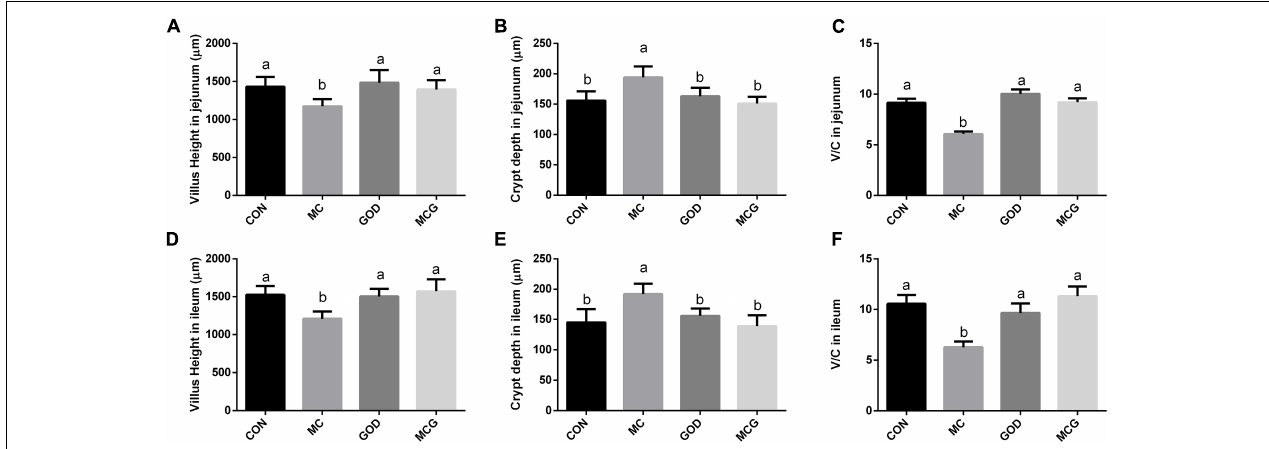
FIGURE 2 | Effects of glucose oxidase on villus height and crypt depth in broiler chickens fed mold contaminated corn. (A) Villus height in jejunum; (B) crypt depth in jejunum; (C) V/C in jejunum; (D) Villus height in ileum; (E) crypt depth in ileum; (F) V/C in ileum. V/C, the ratio of villus height to crypt depth. a , b Means with different letters within columns indicate significant differences at P ≤ 0.05. n =